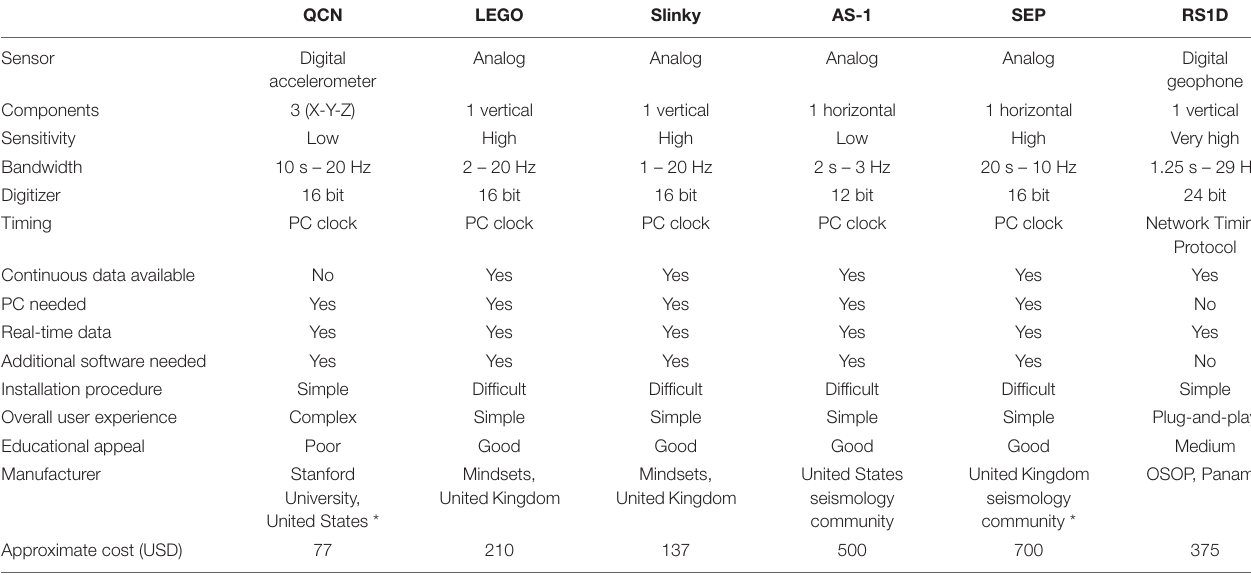
TABLE 2 | List of seismological instruments tested for the educational purposes and comparison of their